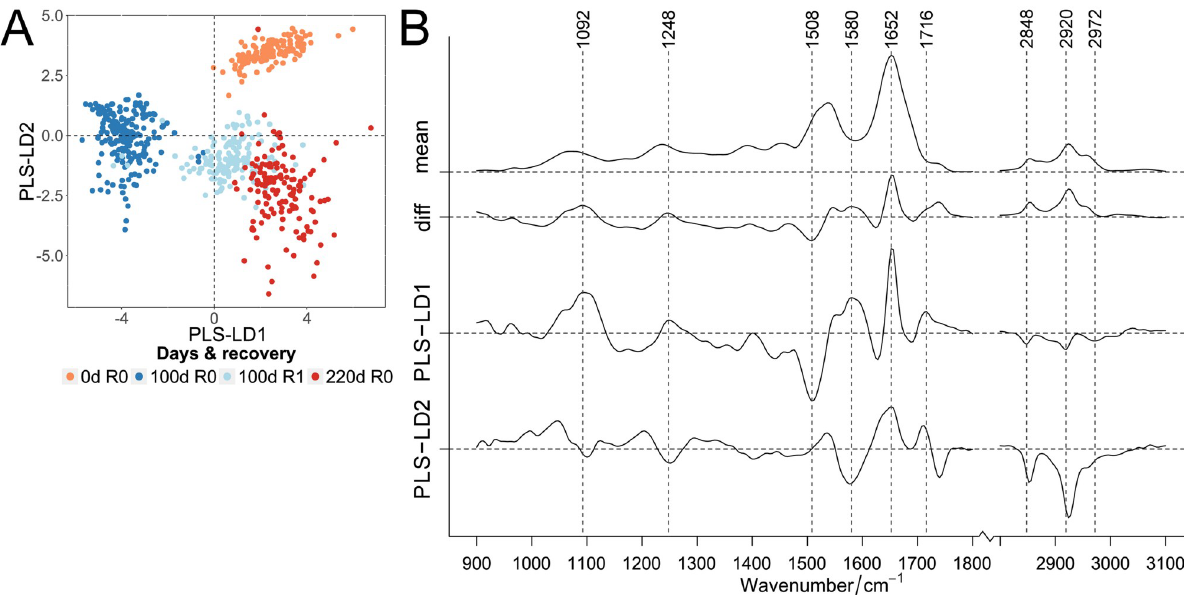
Fig 6. Classification of infrared spectra of proliferating, long-term cultivated quiescent and senescent cells. PLS-LDA scatter plot of FT-IR spectra (A) of proliferating cells (“0d R0”) and 100 days contact-inhibited quiescent cells without recovery (“100d R0”) and recovered from quiescence (“100d R1”) compared to replicative-grown senescent cells (“220 d R0”). Cultivation time (0, 100 and 220 days) and proliferating cells recovered from quiescence (“R1”, pale blue) were specified by color (0 days: orange, 100 days: blue, 220 days: red). Mean and difference spectra (“diff”, 220 d senescence vs. 100 d quiescence “R0”) from the classified cells are plotted together with the PLS-LD1 and -LD2 coefficients vs. the wavenumber (B).